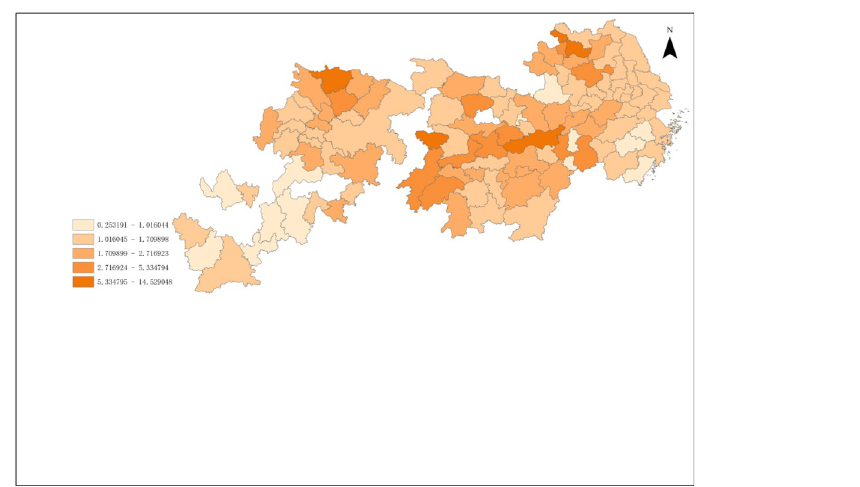
Fig 8. Green total factor productivity of cities in Yangtze River Economic Zone.